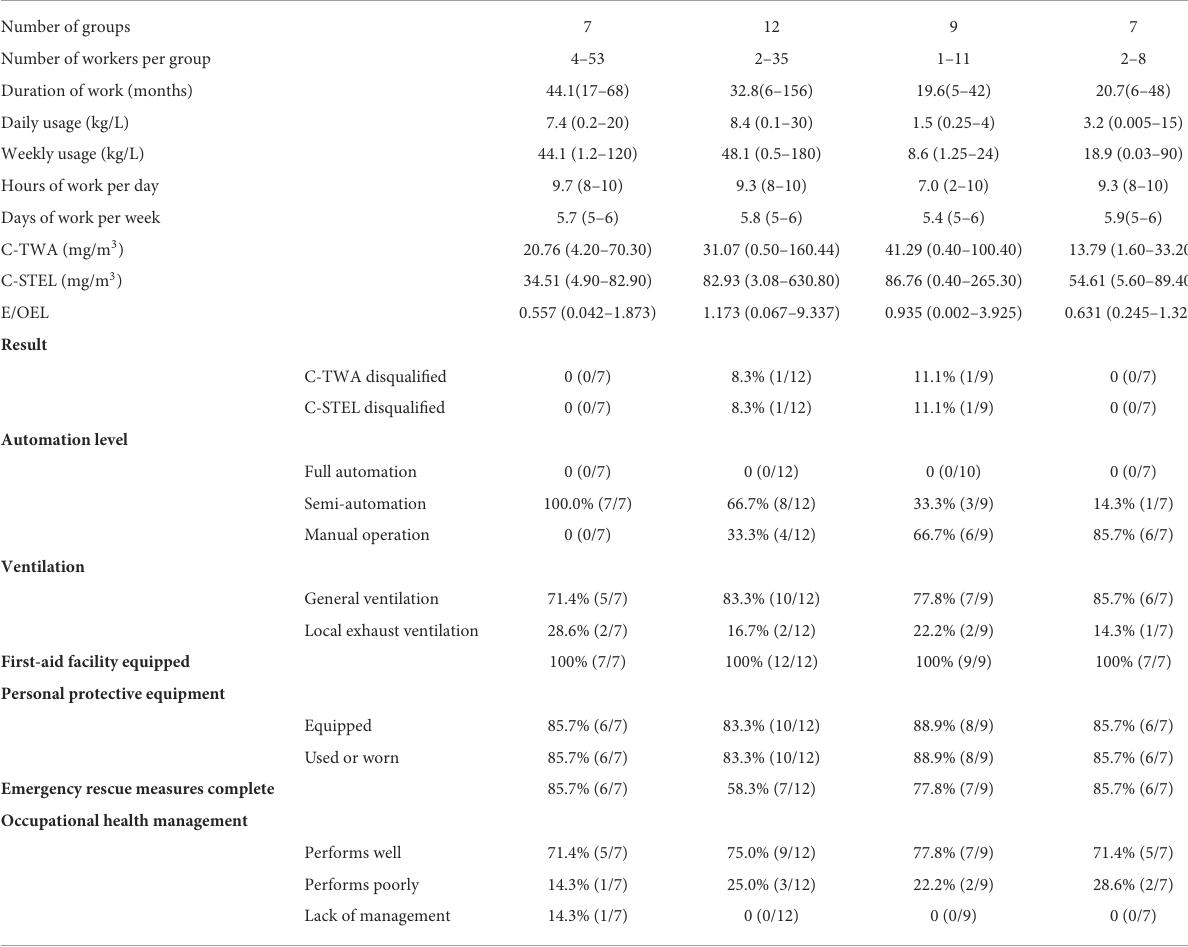
TABLE 1 Survey results of SEGs exposed to n-Hexane. SEG